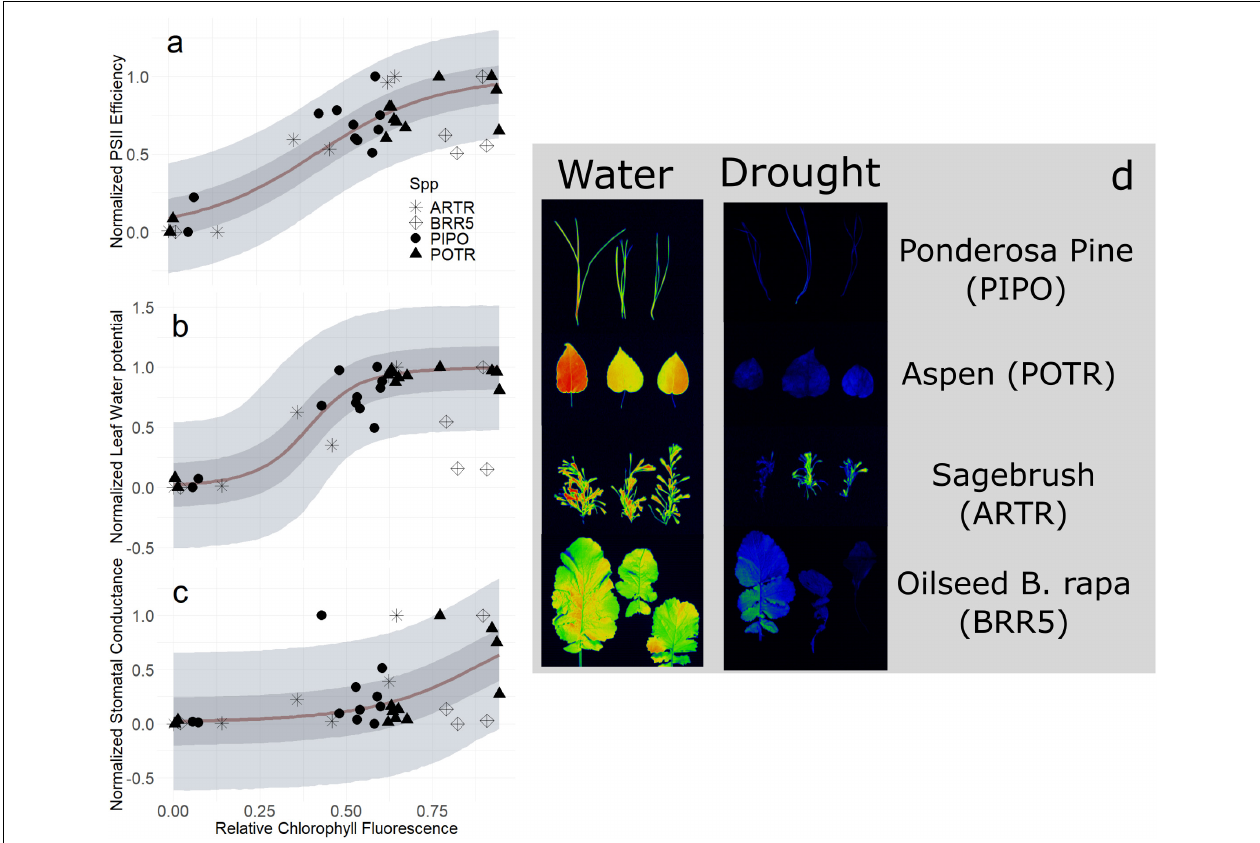
FIGURE 9 | Relative chlorophyll fluorescence ( RChlF ) to normalized physiological responses of midday leaf water potential (PSI L, A ), photosystem II efficiency ( F v (cid:48) /F m (cid:48) , B ), and stomatal conductance (gs, C ) during the progression of both moderate and severe drought experiments. Maximum likelihood estimates (MLE, red) for trends with 50 and 94% creditable intervals for aspen (POTR, triangle), ponderosa pine (PIPO, circle), big sagebrush (ARTR, star), and oilseed Brassica rapa (BRR5, diamond). FluorCam images (D) for well-watered (left) and droughted (right) leaves used for estimating